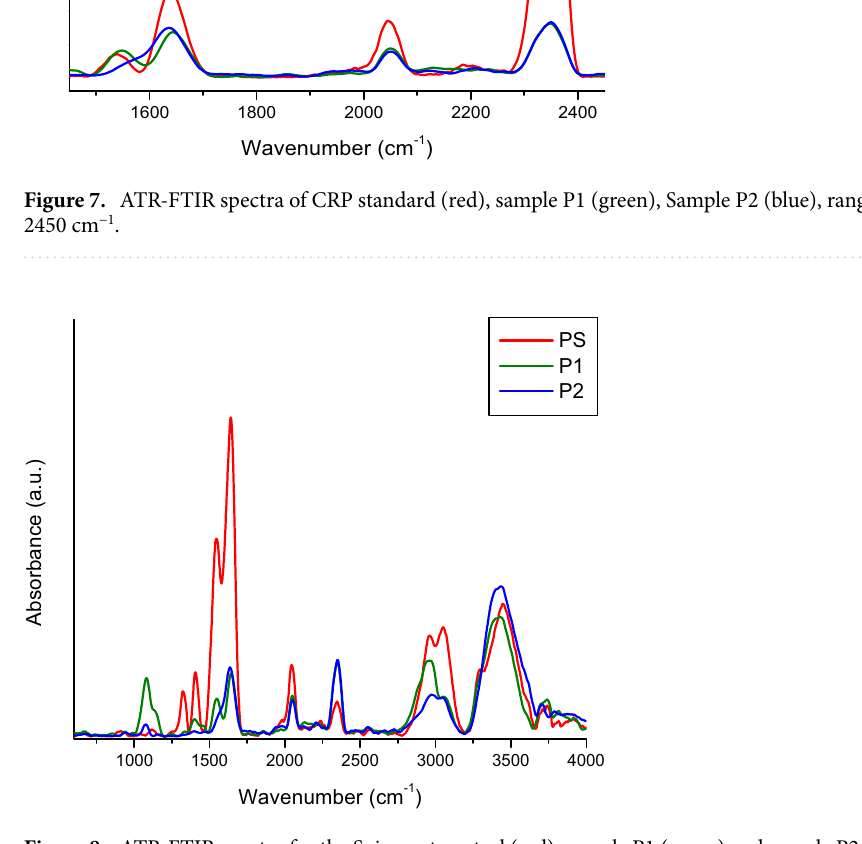
Figure 8. ATR-FTIR spectra for the Spinreact control (red), sample P1 (green) and sample P2